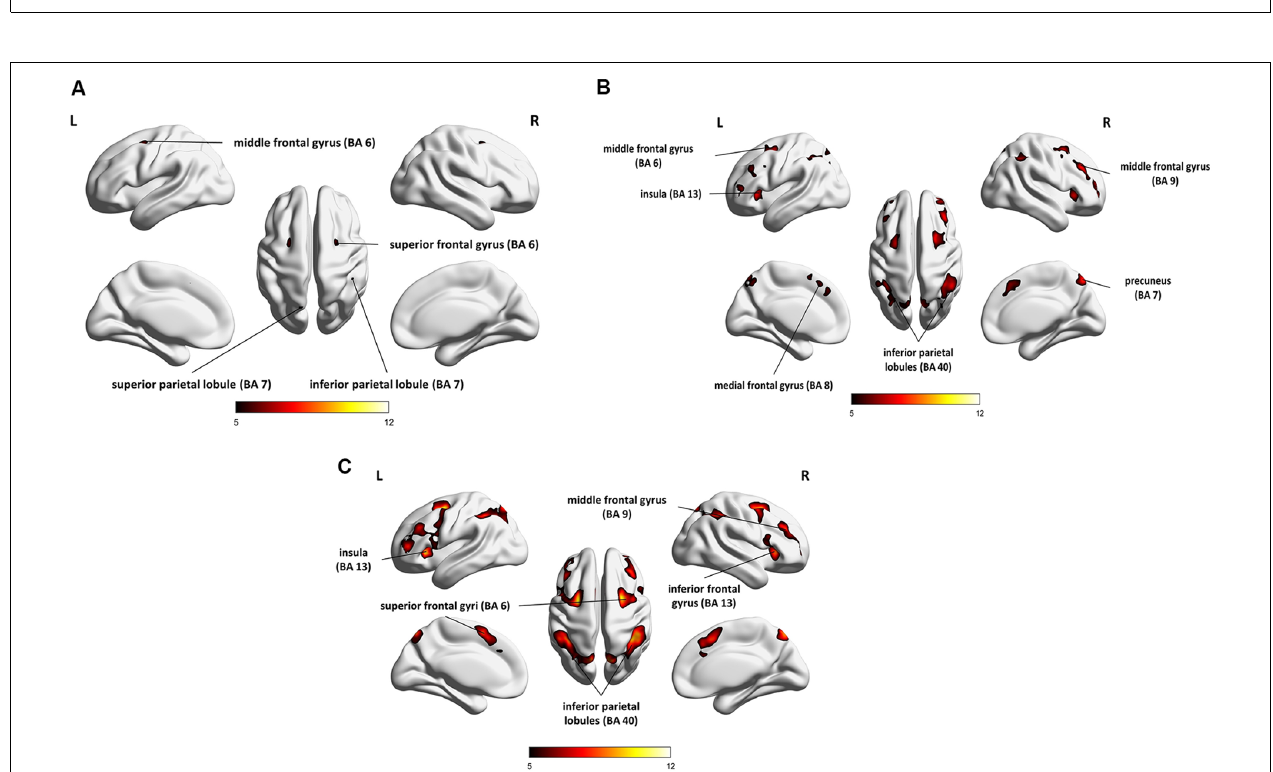
FIGURE 4 | Whole-brain statistical parametric maps representing brain activation specific to: (A) maintenance (1- vs. 0-back), (B) manipulation (2- vs. 1-back), and (C) maintenance with manipulation (2- vs. 0-back). A voxel-level familywise error (FWE) correction was applied ( p < 0.05) with a cluster extent threshold of 10. L, left hemisphere; R, right